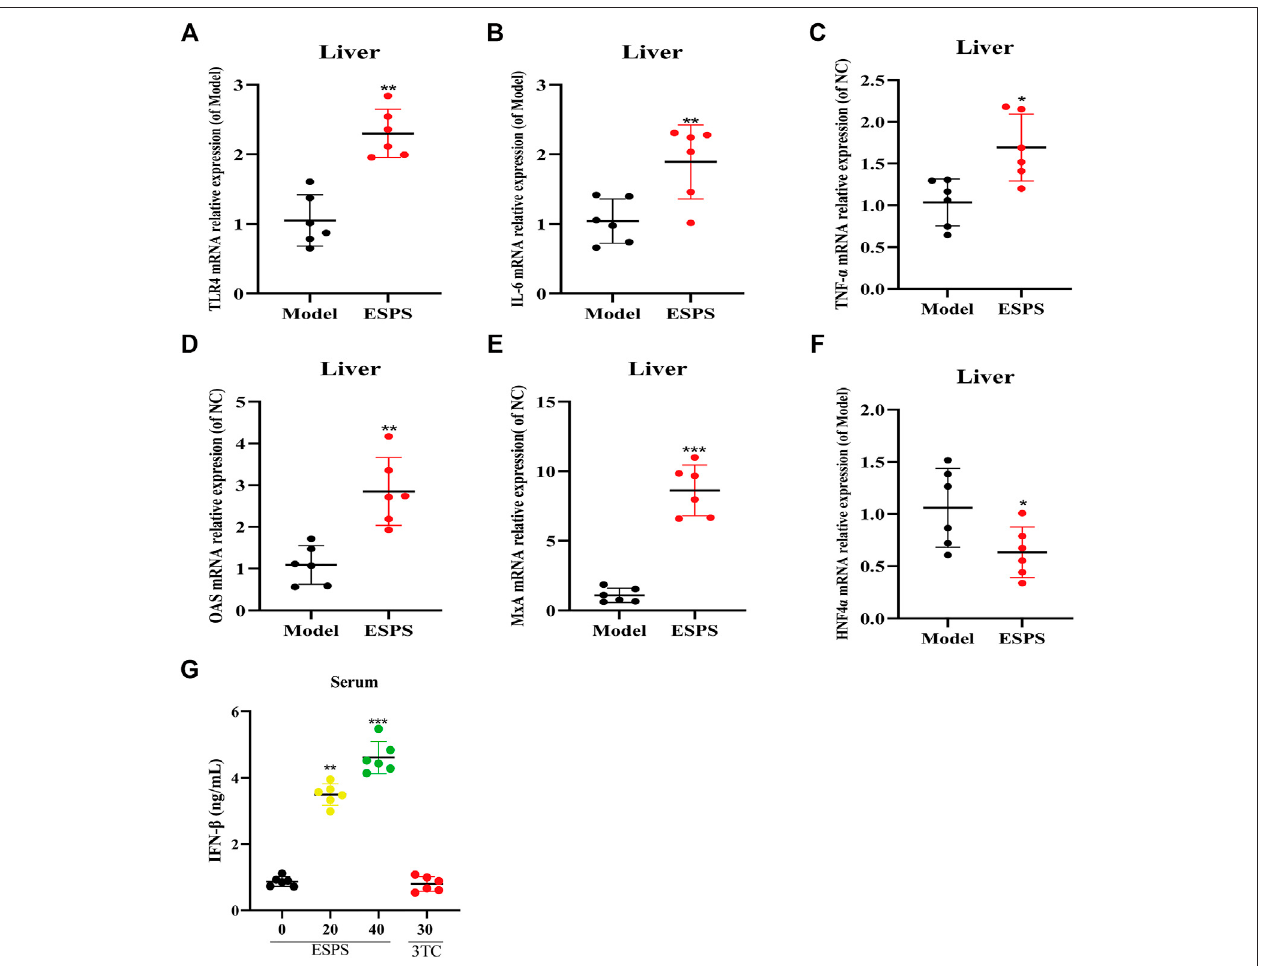
FIGURE6| In fl uenceontheinnateimmunomodulatoryactivitybyESPS invivo .C57BL/6JmiceweretreatedwithESPS(40 mg/kg/2 days)for20 days.ThemRNA relativeexpressions ofTLR4 (A) ,IL-6 (B) ,TNF- α (C) ,OAS (D) ,MxA (E) ,and HNF4 α (F) inlivertissueofmice weredetected byqPCR. Comparison betweengroupswas performed by t -test analysis. Values are means ± SD ( n = 6). * p < 0.05, ** p < 0.01, *** p < 0.001 vs . the model group. Serum IFN- β was analyzed by ELISA kit (G) . Values are means ± SD ( n = 6). *** p < 0.001 vs . the model group.